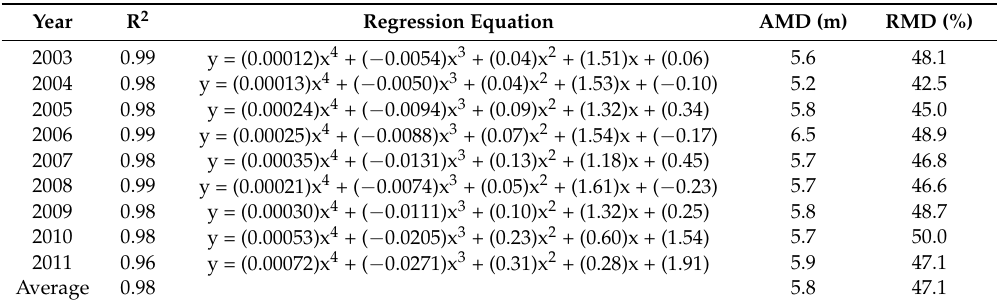
Table 5. Summary of pixel-based comparison of monthly MERIS-derived SD values using the Doron11 algorithm and those using Lee15 algorithms in Lake Malawi during the study period. The absolute mean difference (AMD) is calculated as averaged |Doron11_SD – Lee15_SD|, and the relative mean difference (RMD) is calculated as averaged |Doron11_SD – Lee15_SD|/ Lee15_SD × 100.